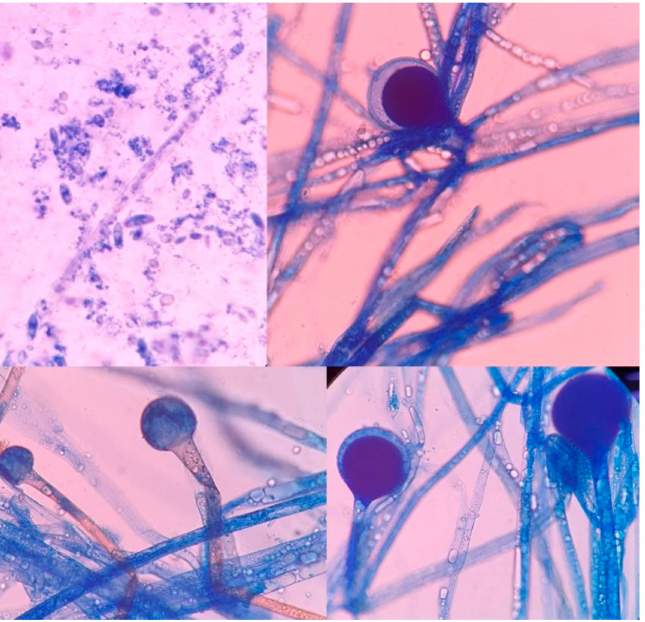
Figure 7. High-power photomicrograph showing the sporangia (Lactophenol cotton blue stain). The wall of the sporangium dissolves on maturity, exposing the spores.